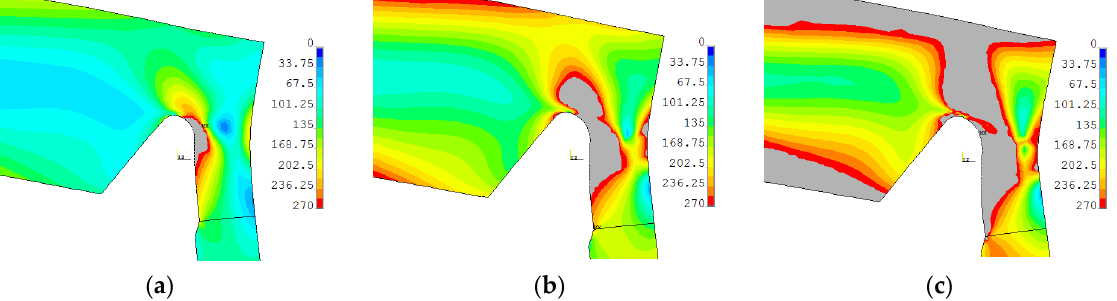
Figure 16. Equivalent von Mises stress in non-optimal SRG with mean dimensions, material 2P for: ( a ) cycle 6—22 MPa; ( b ) cycle 14—35 MPa; ( c ) cycle 26—41 MPa. Areas in which yield limit (270 MPa) has been exceeded are marked with gray color.